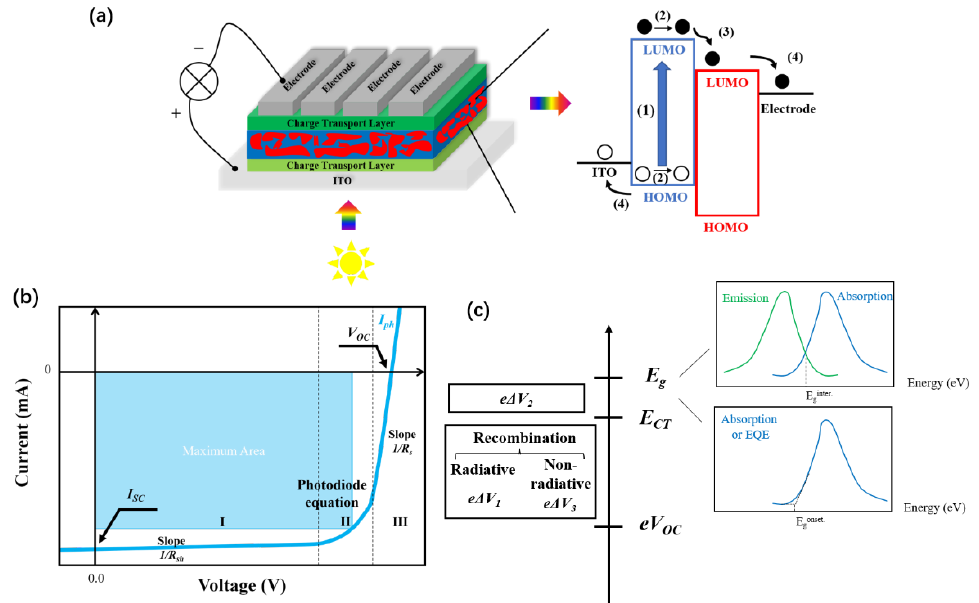
Figure 2. ( a ) The schematic structure of a bulk-heterojunction (BHJ) solar cell where the blue regions represent donors and red regions represent acceptors. The enlarged picture on the right shows four basic working steps of a BHJ solar cell. ( b ) Generic J-V graph for the performance of a solar cell. ( c ) Different forms of energy losses with two methods calculating the bandgap shown on the right.